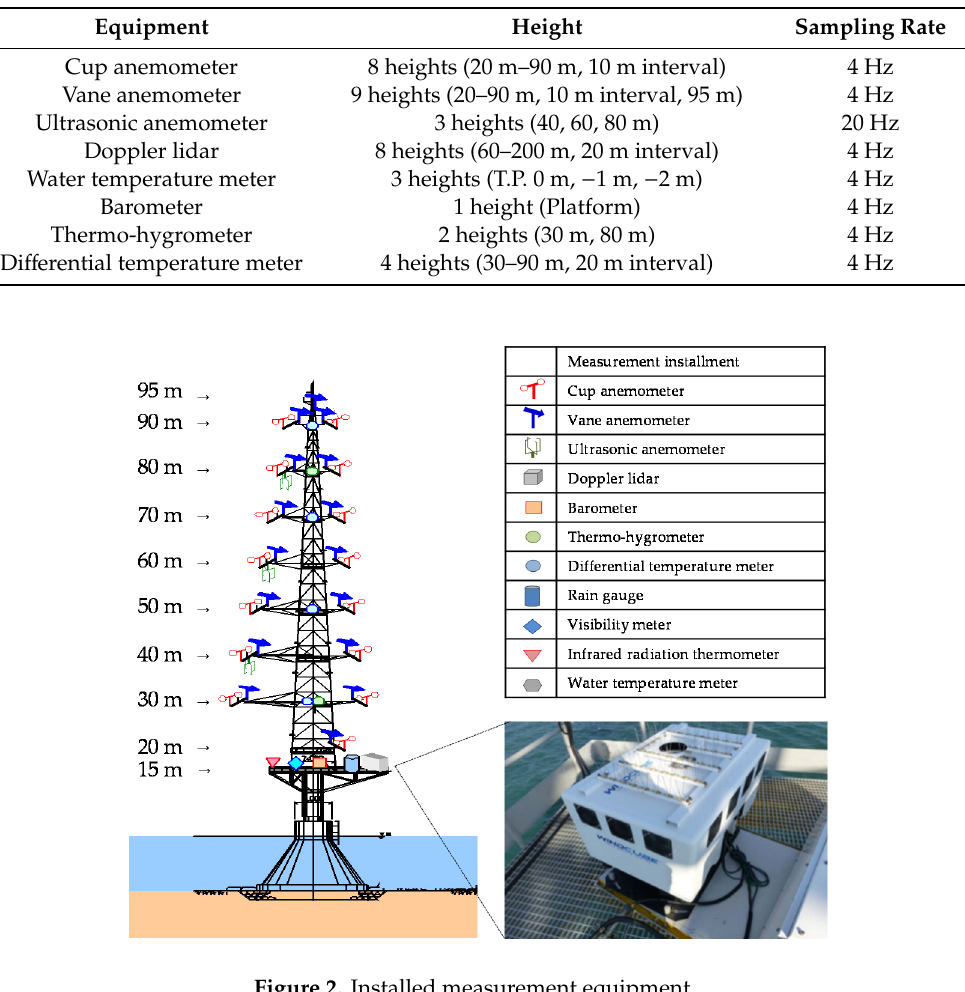
Figure 2. Installed measurement equipment.